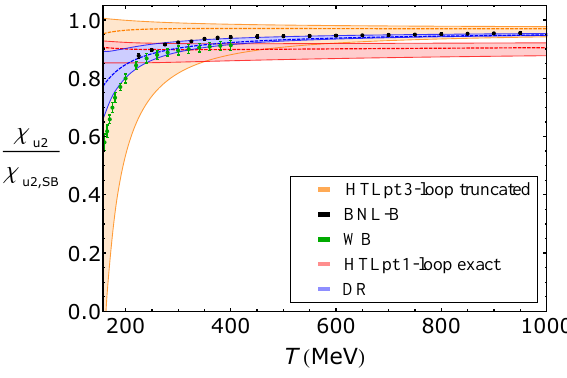
Figure 1. Second-order diagonal quark number susceptibility, normalized to its non-interacting limit. The truncated three-loop HTLpt result is from [37] and the lattice data from the BNL–Bielefeld [38] (BNL–B) as well as from the Wuppertal–Budapest [39] (WB)